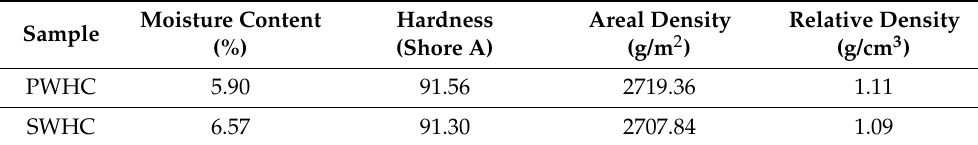
Table 4. Moisture content and hardness of the PWHC and